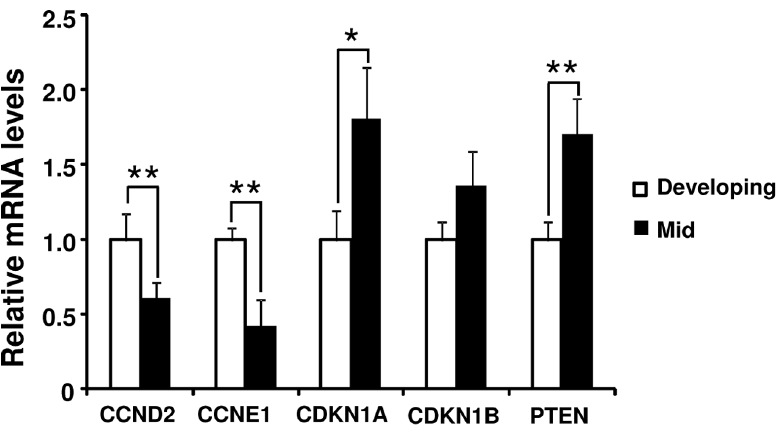
Figure 3. Cell cycle-related genes and PTEN expression in bovine freshly isolated LSCs. Fold differences of cell cycle- related genes such as CCND2 , CCNE1 , CDKN1A , CDKN1B and tumor suppressor gene PTEN mRNA between freshly isolated developing LSCs and mid LSCs. Single and double Asterisks indicate significant differences (* ; P<0.1, ** ; P<0.05), as determined by ANOVA followed by Fisher’s PLSD as a multiple comparison